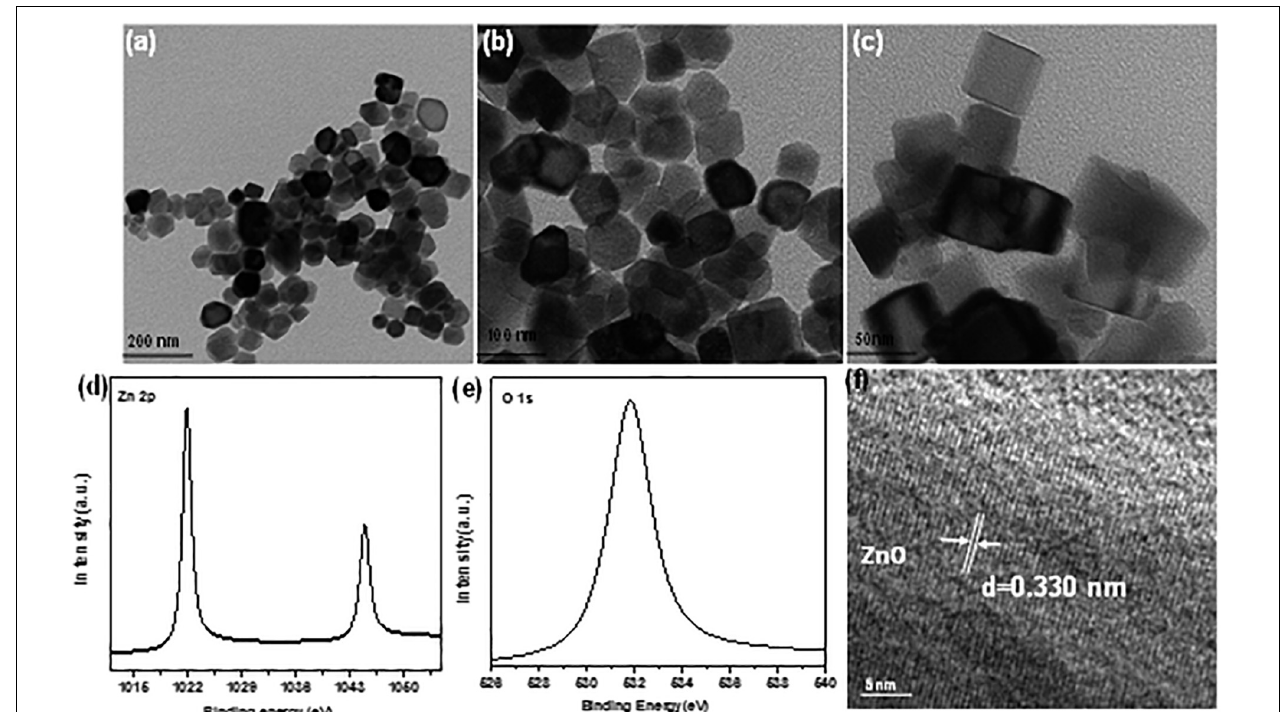
FIGURE 2 | TEM micrograph images of panels (a–c) ZnO nano boxes (d,e) XPS of Zn 2p and O 1s (f) HRTEM of